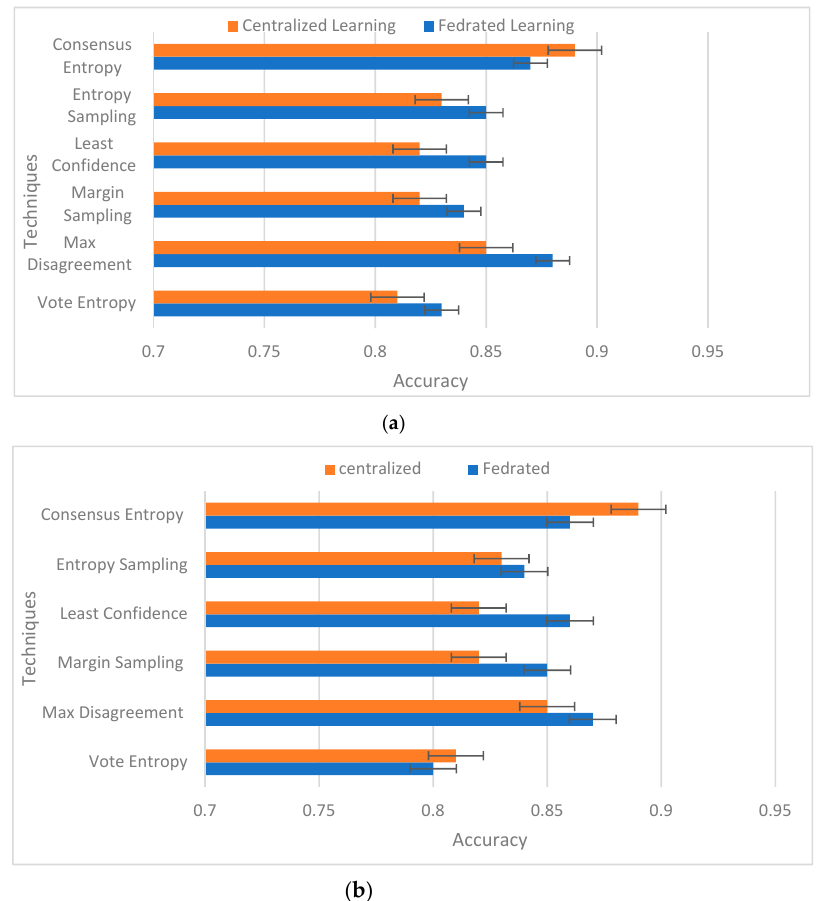
Figure 5. Comparison of FL versus centralized learning contexts based on six participating nodes in various AL techniques. ( a ) Human sentiments; ( b ) Human physical activities.